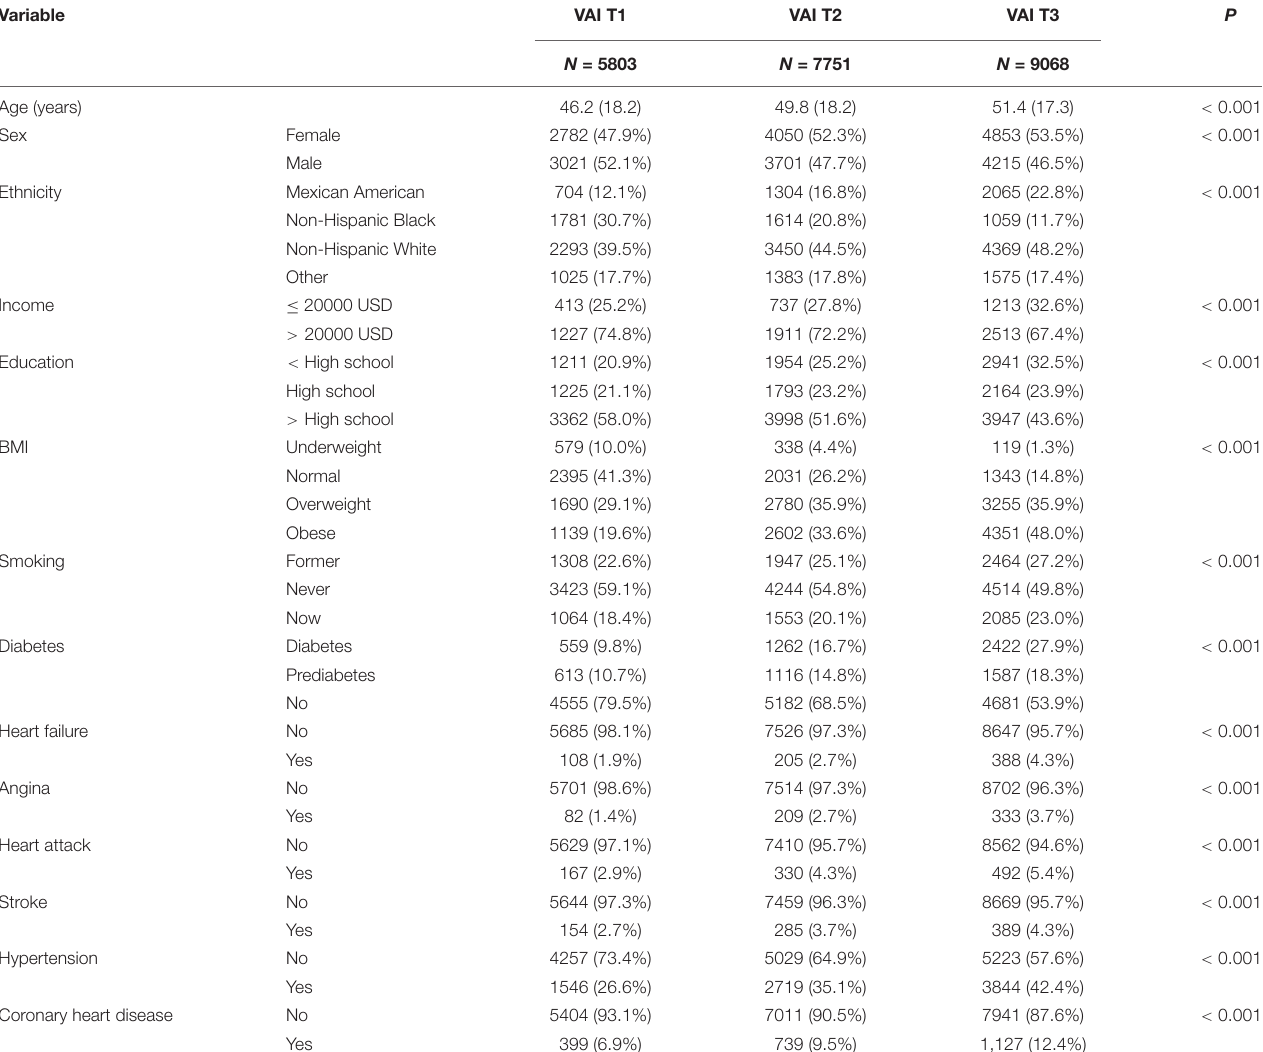
TABLE 2 | Characteristics of NHANES samples